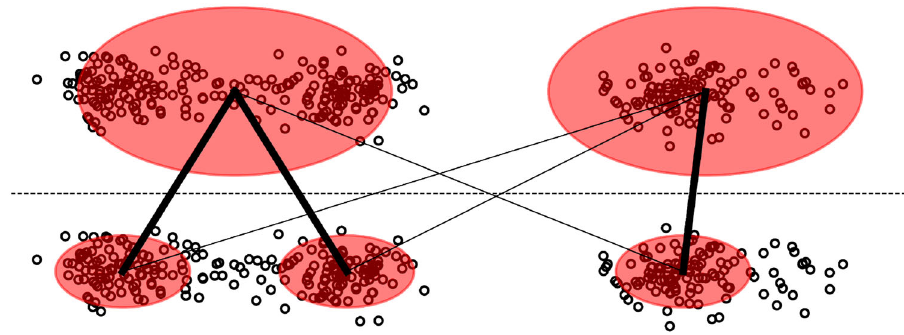
Fig. 2 Distances for all pairs of clusters of consecutive ε levels have to be computed to find the closest and most likely parent